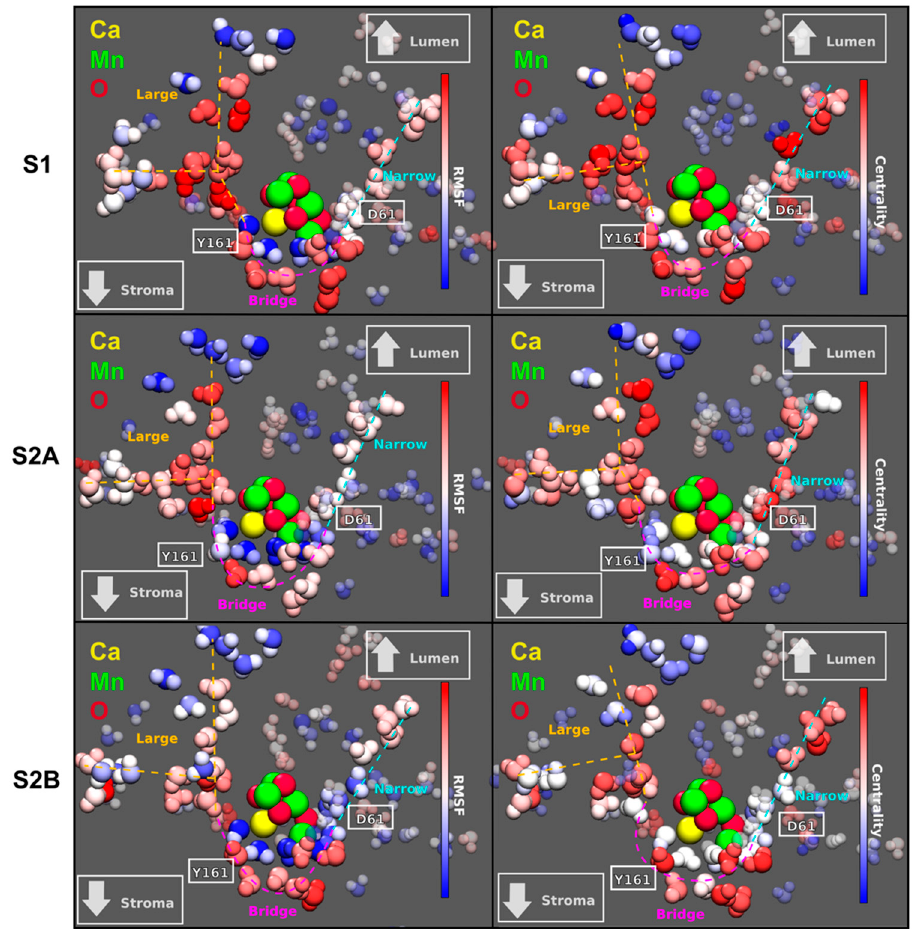
Figure 2. Left: Root Mean Square Fluctuation (RMSF) per water molecule for three different S-states of the OEC. The color scale is red for highly mobile water molecules and blue for the most static waters. Right: Eigenvector centrality in terms of the mutual information metric computed for the OEC complex in two different states: S 1 and S 2 , having two isomers of S 2 . The centrality scale goes from red (high centrality) to blue (low centrality). Relative positions of D1–D61 and Y161 are shown in white. The channels colored in cyan, magenta, and orange are named narrow, bridge, and large, respectively. Both the large and the narrow channel have already been recognized in several studies [13–15]. The bridge channel, on the other hand, only coincides a fragment of the so-called broad channel.